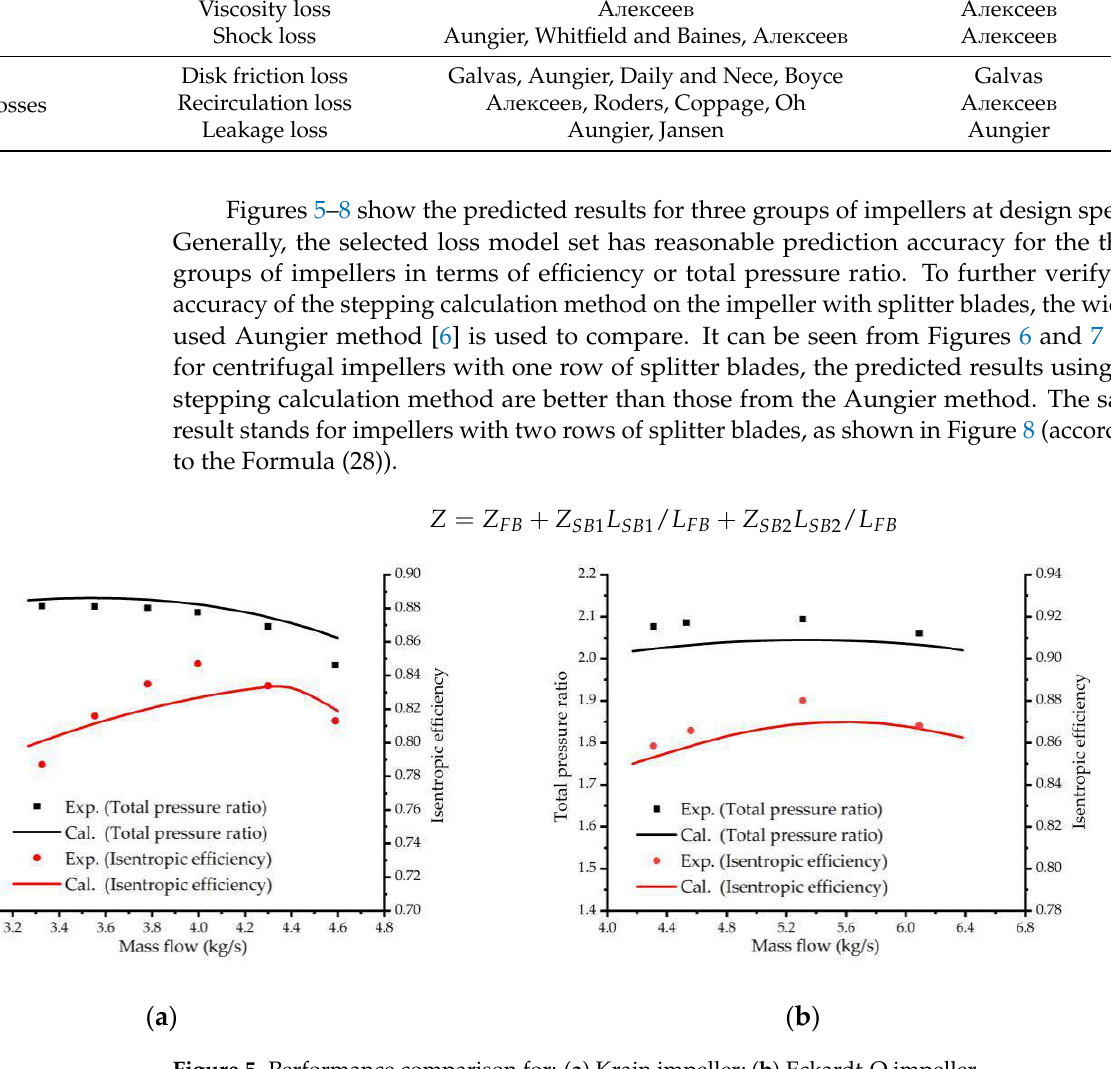
Figure 5. Performance comparison for: ( a ) Krain impeller; ( b ) Eckardt-O impeller.